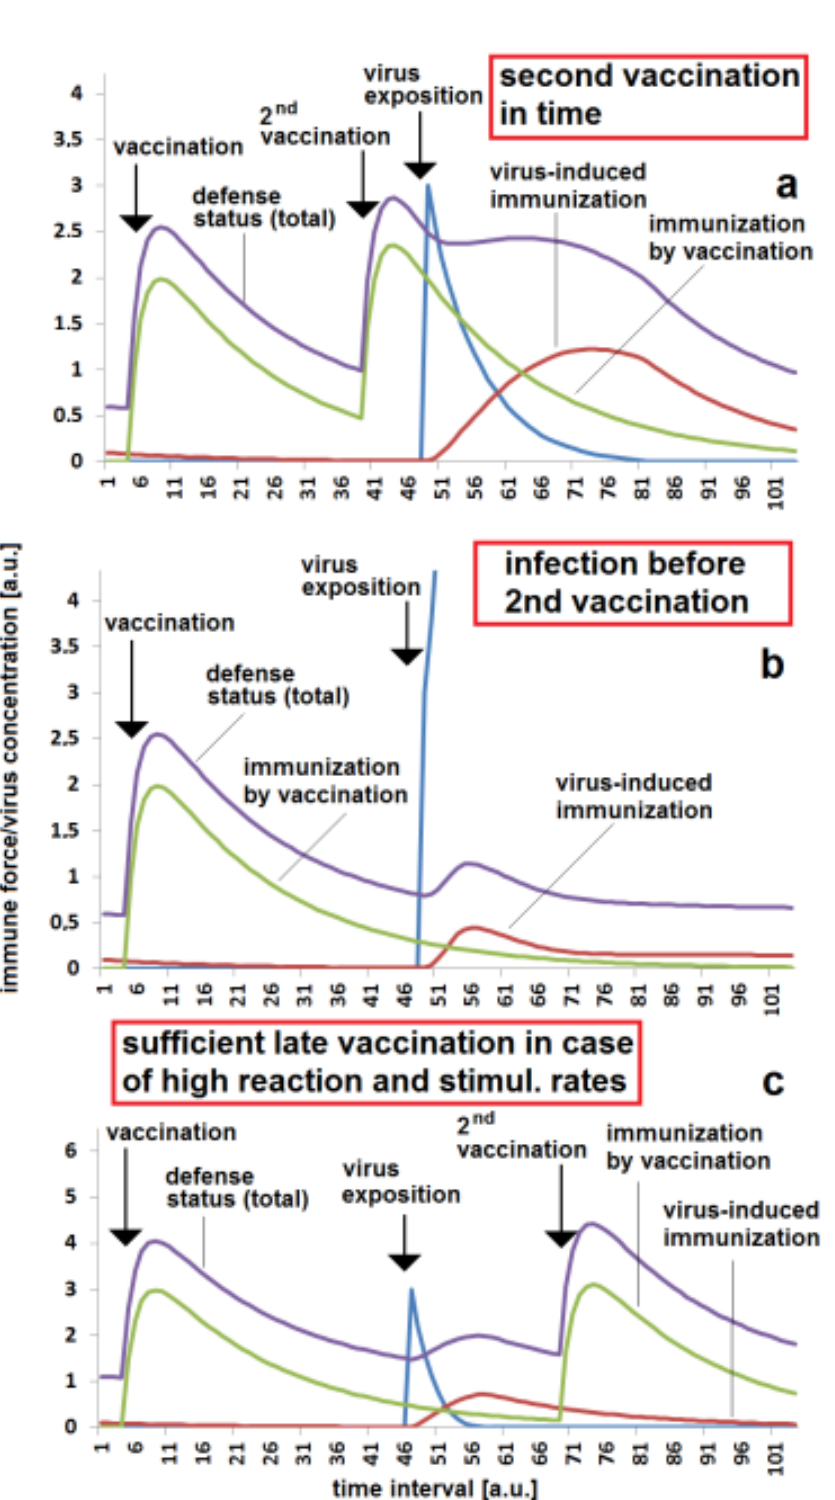
Figure 5. Importance of second immunization date with respect to reaction and stimulation rate: ( a ) safe protection due to second vaccination being given in time, k r = 0.1 and k st = 0.05; ( b ) disease breakthrough in the case of a low virus-induced immunization effect and second vaccination not being given in time, k r = 0.1 and k st = 0.05; ( c ) sufficient late vaccination due to higher reaction and stimulation rates, k r = 0.3 and k st = 0.15. The set of other parameters for the simulations ( a – c ): k vir = 0.3; D vacc = 0.05; D AB = 0.05; c BGim = 0.5; v oo = 30; st oo = 10.